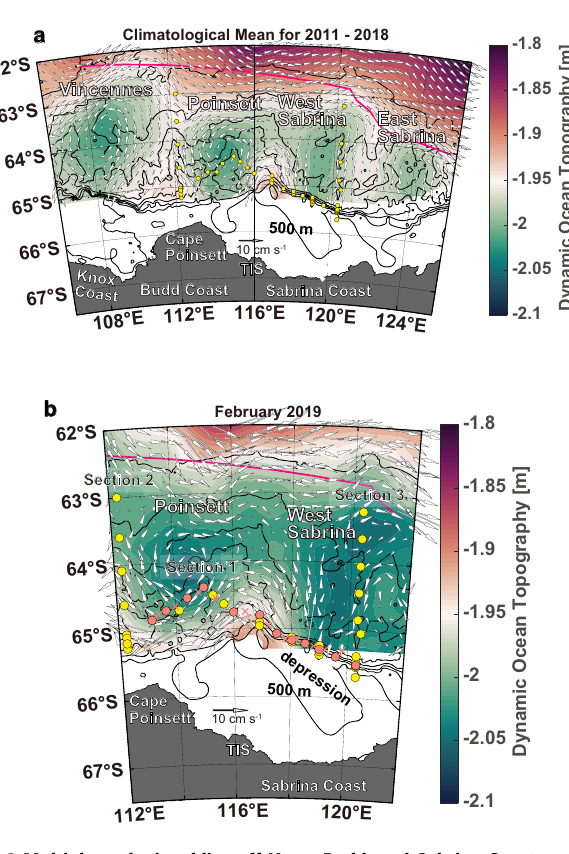
Fig. 2 Multiple cyclonic eddies off Knox, Budd, and Sabrina Coasts. Spatial distributions of satellite-derived dynamic ocean topography (DOT, color) and surface velocity (vector). a Climatological mean for 2011 – 2018 and b February 2019 (corresponding to the period of the conductivity – temperature – depth (CTD) observations at Sta. 501 – 529). Yellow circles represent the positions of CTD stations. Orange circles indicate the positions of hydrographic pro fi les used for absolute velocity calculations (Fig. 3d), while orange crosses are the grids for the referenced DOT-derived surface velocity in the calculations. The pink line represents the southern boundary of the Antarctic Circumpolar Current 8 . From west to east, cyclonic eddies comprising the “ eddy train ” are the Vincennes Eddy, Poinsett Eddy, West-Sabrina Eddy, and East-Sabrina Eddy 18